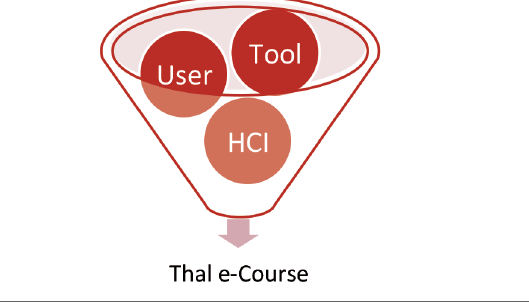
Figure 3. Instructional design